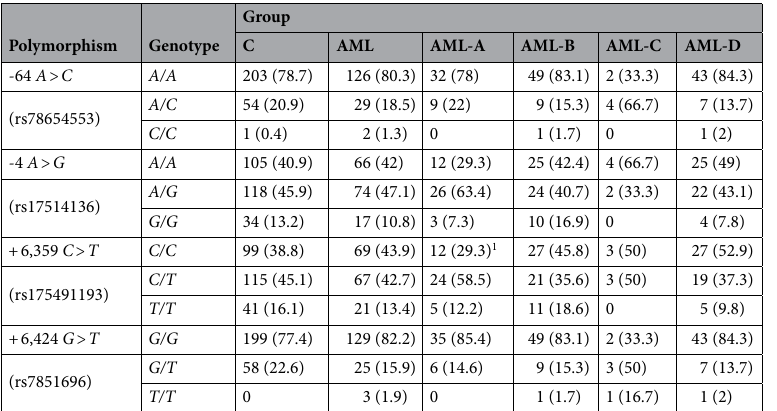
Table 2. Frequency of genotypes associated with selected FCN2 single nucleotide gene polymorphisms. Percentages are shown in parentheses. Allele distributions were in accordance with Hardy–Weinberg equlibrium. C: controls; AML-A: patients who experienced infections with proven bacteremia and/ or fungaemia; AML-B: patients who experienced infections with no bacteremia; AML-C: patients who experienced febrile neutropenia; AML-D: patients who experienced none of afore-mentioned complications within 4 weeks of hospital stay. 1 p = 0.033, OR = 0.37, 95% CI (0.15–0.88) (vs.